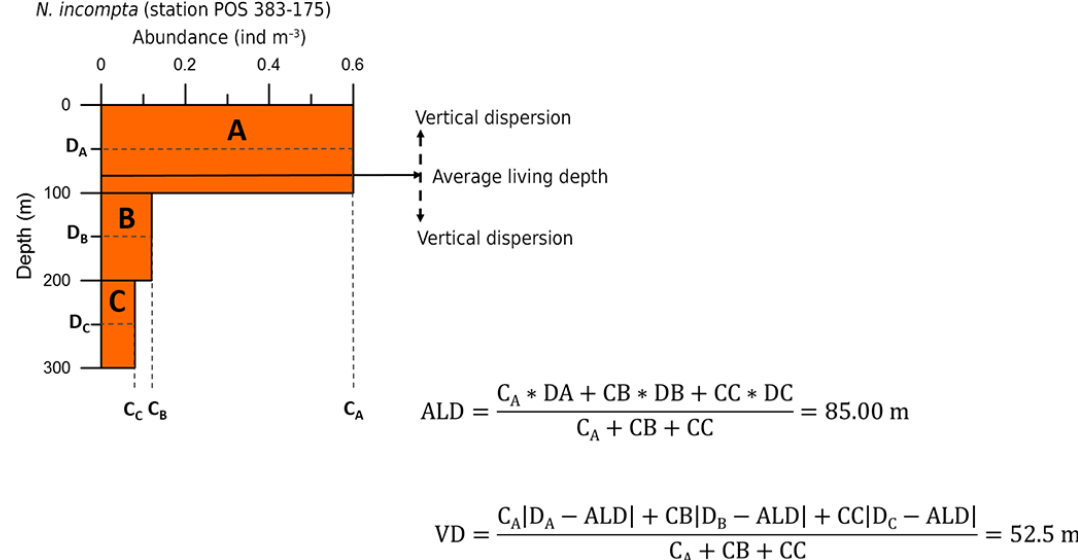
Figure 4. An example of a vertical distribution of live specimens of Neogloboquadrina incompta in the upper three sampling intervals (indicated as A, B and C) of station POS 383-175. The diagram is used to illustrate how the vertical habitat of a species is expressed by average living depth (ALD), calculated as the average of the sampling depths ( D A , D B and D C ) weighted by the abundance concentration at these depths ( C A , C B and C C ) , and vertical dispersion (VD), calculated as the mean distance of the population from the